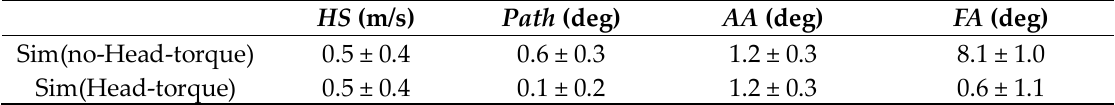
Figure 14. Comparison of measured and simulated results of FA . The triangle marks ( ▲ ) show the result without Head-torque, and the circle marks (●) show Head-torque. Table 2. Difference between measured and simulated results of club head